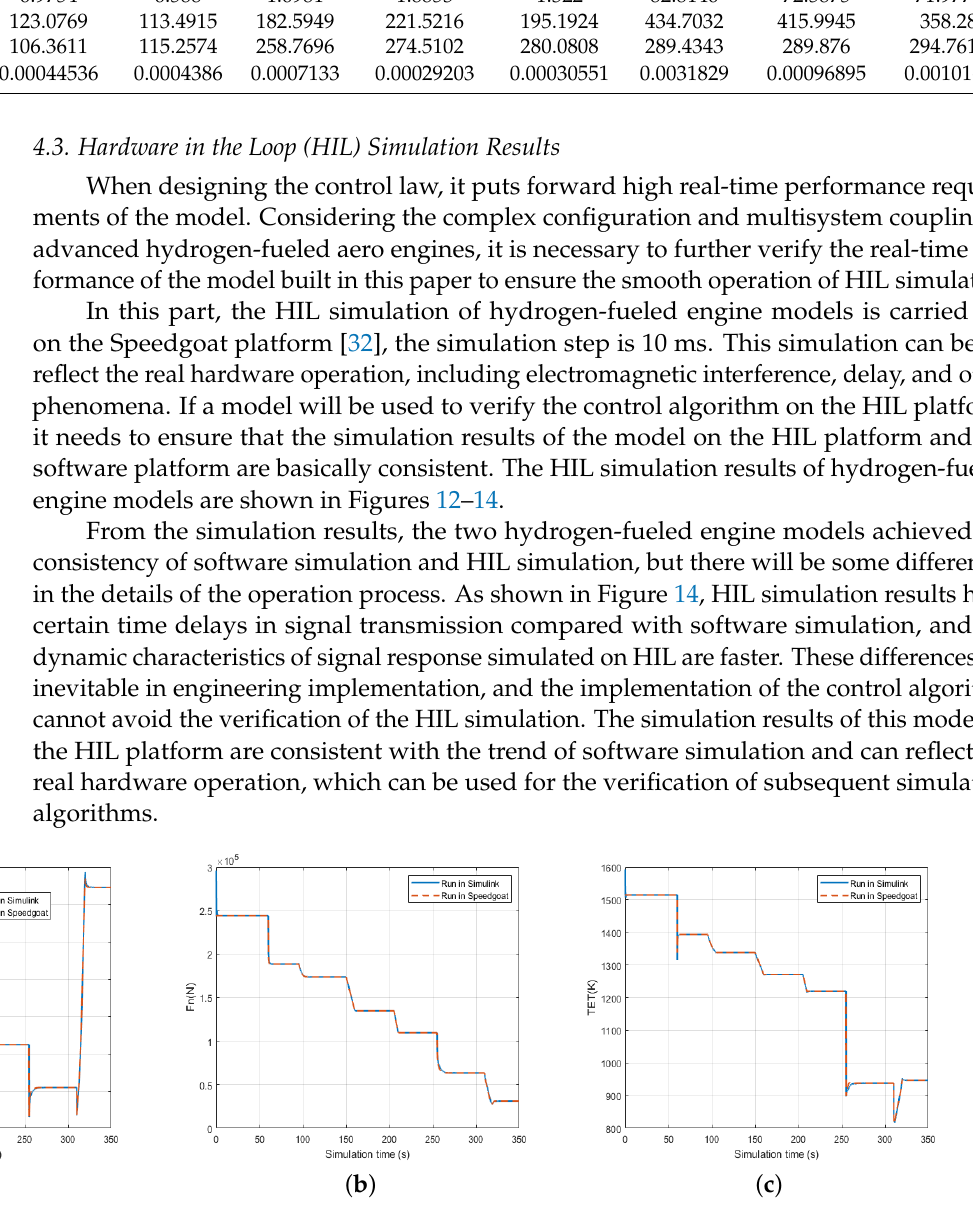
Figure 12. Comparison of HIL simulation and software simulation results of the ENABLEH2 scheme: ( a ) the SFC results; ( b ) the thrust results; and ( c ) the TET